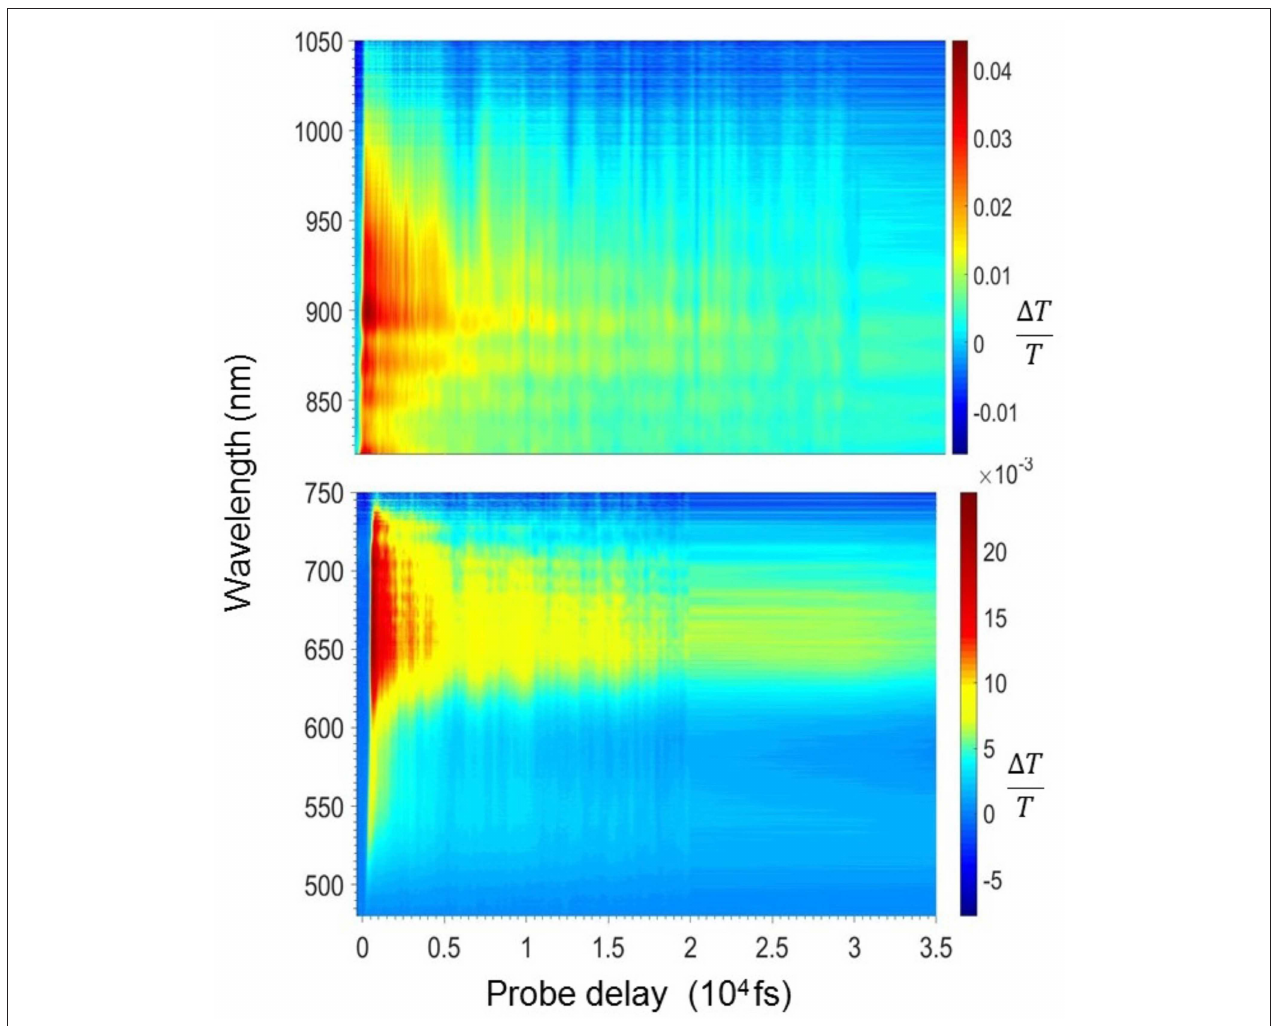
FIGURE 5 | 2-Dimensional 1 T / T map in the near infrared (bottom panel) and the visible (top panel) region for the LMM mesoparticle suspension.